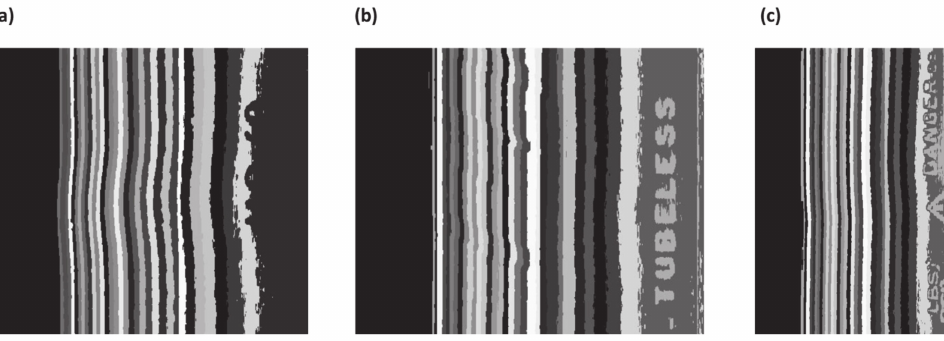
Figure 9. K-Means image processing: ( a ) distributed stress defect; ( b ) local defects; ( c ) partially distributed local